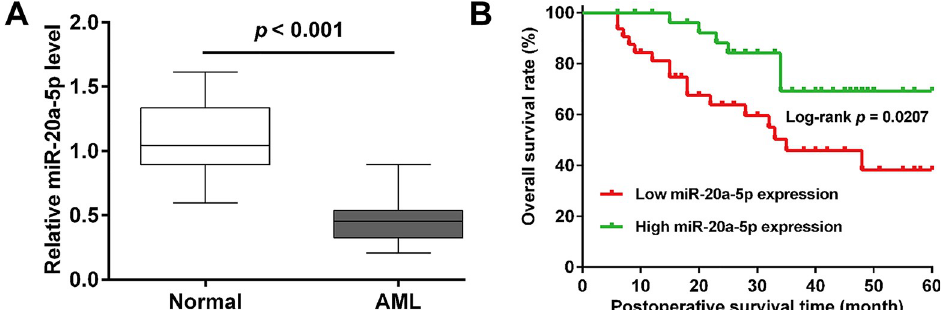
Fig 1. The expression and prognosis of miR-20a-5p in AML patients. (A) Expression of miR-20a-5p in bone marrow from AML (n = 61) and age matched healthy volunteers (n = 61) were detected by quantitative real time PCR analysis. (B) Kaplan–Meier analysis of overall survival rate of AML patients with low or high miR-20a-5p expression.